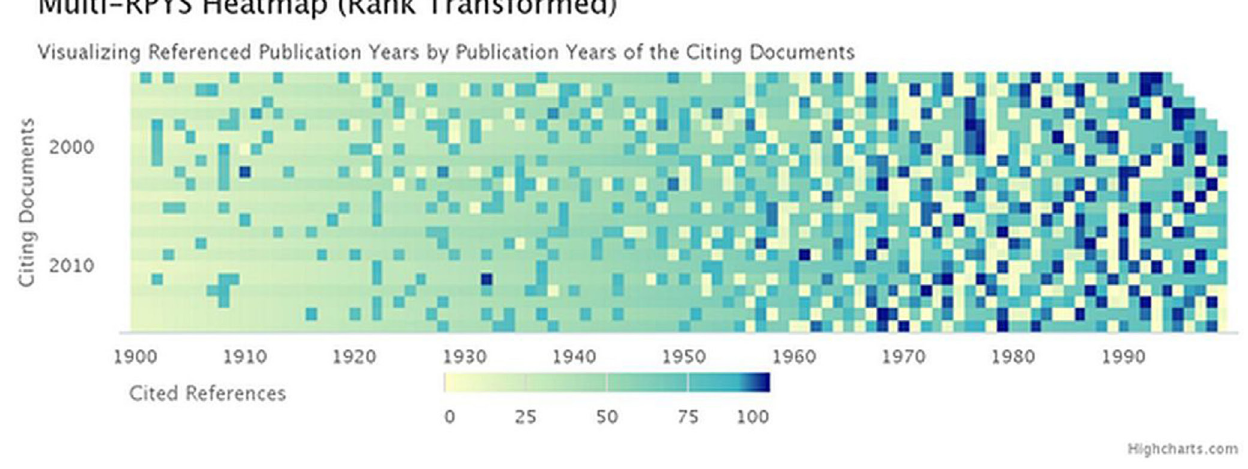
FigUre 12 | 524 documents published in Soziale Welt since its first edition in 1949; downloaded on February 14, 2016 . Source: http://comins. leydesdorff.net